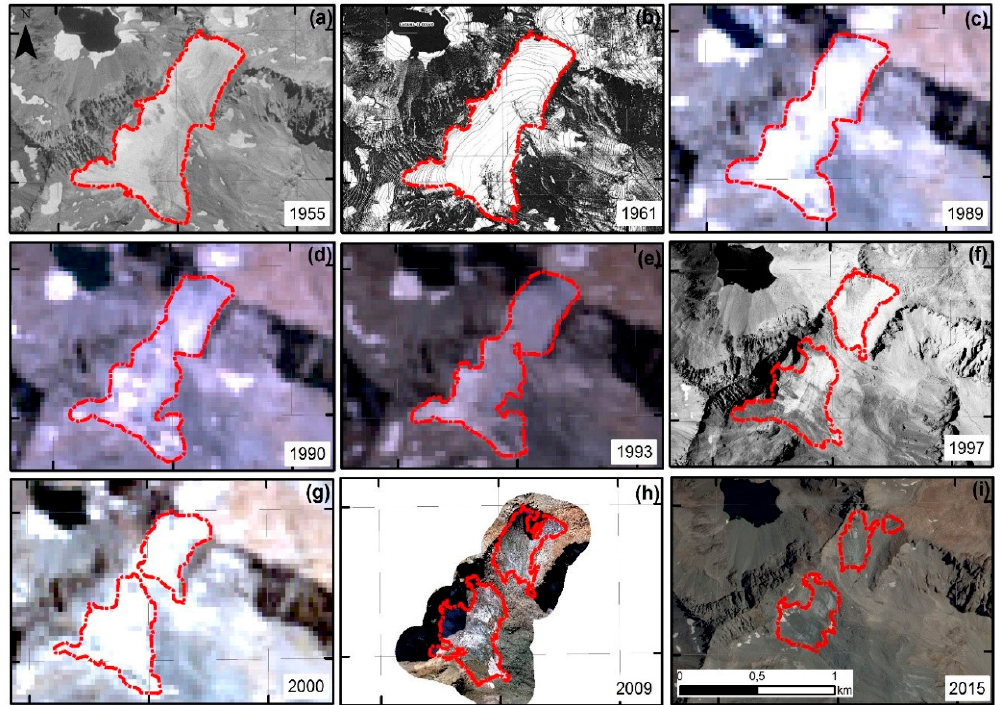
Figure 2. Area changes in the Echaurren Norte Glacier between 1955 and 2015. ( a , b , f , h ) corresponds to aerial photographs, ( c – e , g ) Landsat TM images (321 band composite) and ( i ) SPOT image. Note that in the late 1990s the glacier split up in two smaller ice bodies that are being gradually covered by debris. (See Table 1 for details)